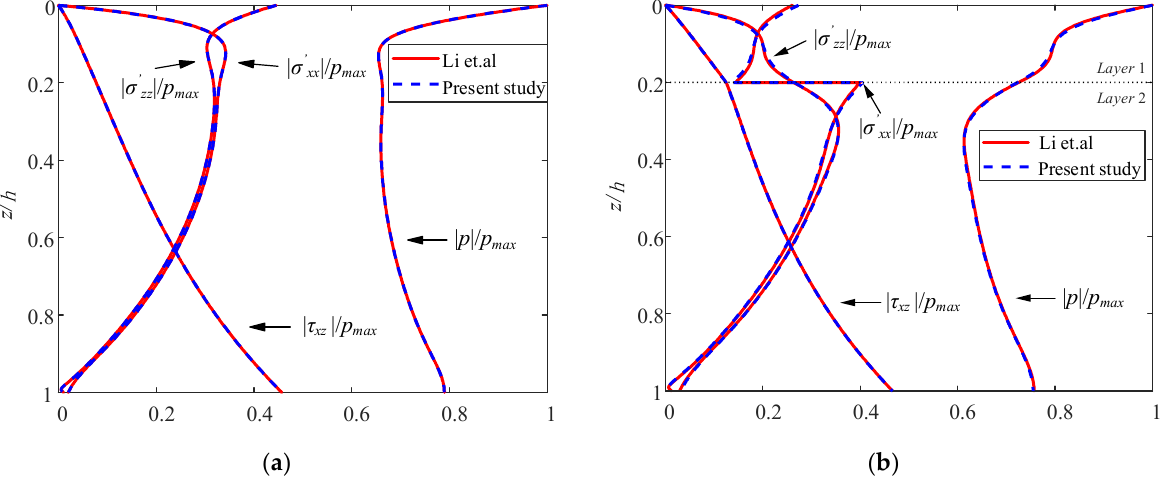
Figure 4. Comparisons of the vertical stress distributions of ( a ) a single-layered seabed and ( b ) a two-layered seabed between Li et al. [38] (solid lines) and present study (dash lines). Table 1. Wave conditions and isotropic soil properties [38].